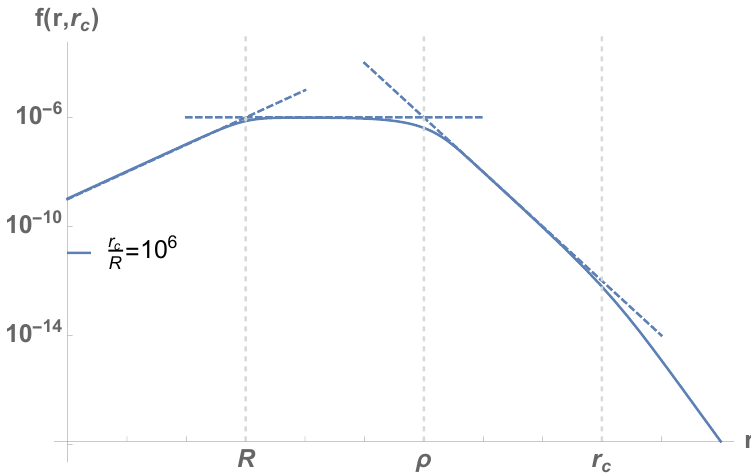
Figure 6. This log-log plot shows the numerical value of f , de(cid:12)ned in (A.2), as a function of r (in units of R ) for the ratio r c =R = 10 6 as a solid curve. The dashed curves are the functions r for r . R , 1 for R . r . (cid:26) and 1 for r & (cid:26) (with again r and r c in units of R ). We see r c r c r 2 that f is approximated very well by the three asymptotes in the three stated regimes. The dashed vertical lines show the scales, which separate the regimes, mentioned in section 3. We observe that already for r c =R = 10 6 , the regime (II), where the force can be approximated as constant, extends